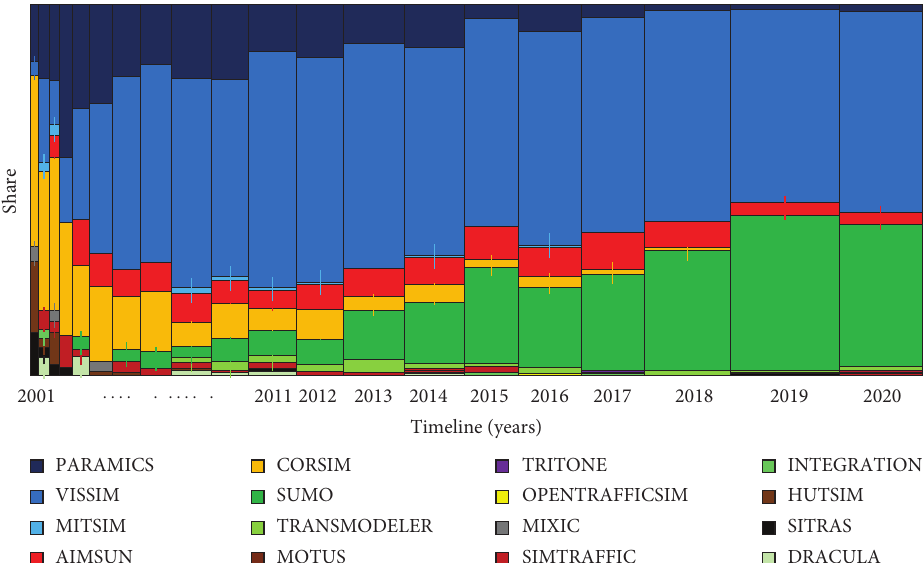
Figure 4: Publication share of microsimulation platforms over the years.